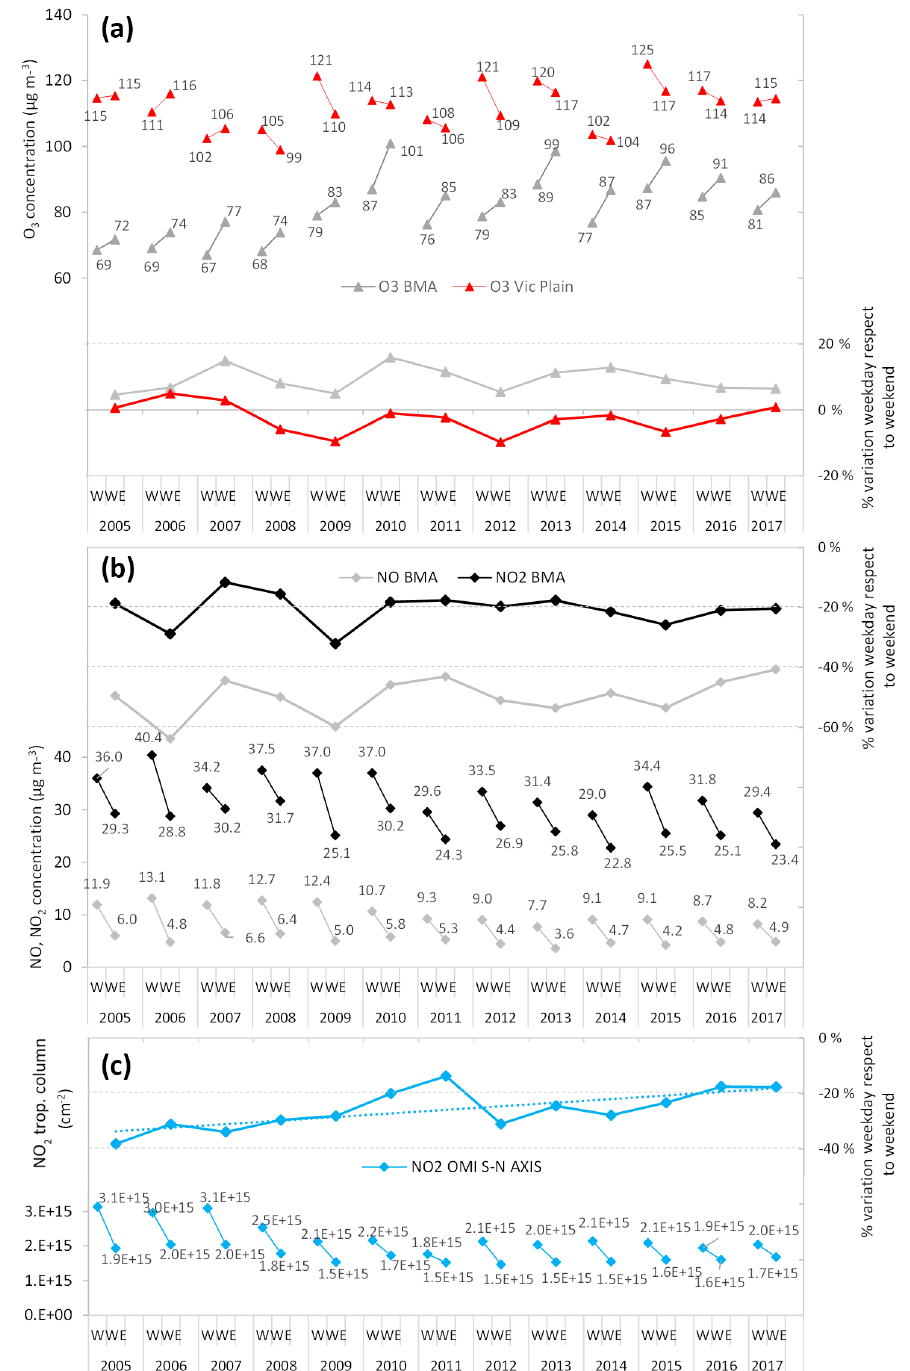
Figure 8. Weekday (W) (Monday to Friday in the BMA and Tuesday to Friday in the Vic Plain) to weekend (WE) pollutant concentrations (O 3 , NO and NO 2 ) measured at AQ sites and background NO 2 (remote sensing OMI) for June to August, per year along the period 2005– 2017. O 3 concentrations (a) are averaged from 12:00 to 19:00LT hourly concentrations, and NO and NO 2 concentrations are calculated from daily averages, including OMI-NO 2 . Each short line depicts the increasing or decreasing tendency of weekday concentrations (left side of each short line) with respect to weekend levels (right side of the short lines). Thus, a horizontal line would represent same pollutant levels along the week (concentration in W = concentration in WE). We consider BMA AQ sites CTL, MON and GRA, and Vic Plain AQ sites TON and MAN. The continuous lines show the percentage of variation of pollutant levels during weekends with respect to weekdays: increasing ( > 0) or decreasing ( < 0), i.e., a quantification of the inclination of each short